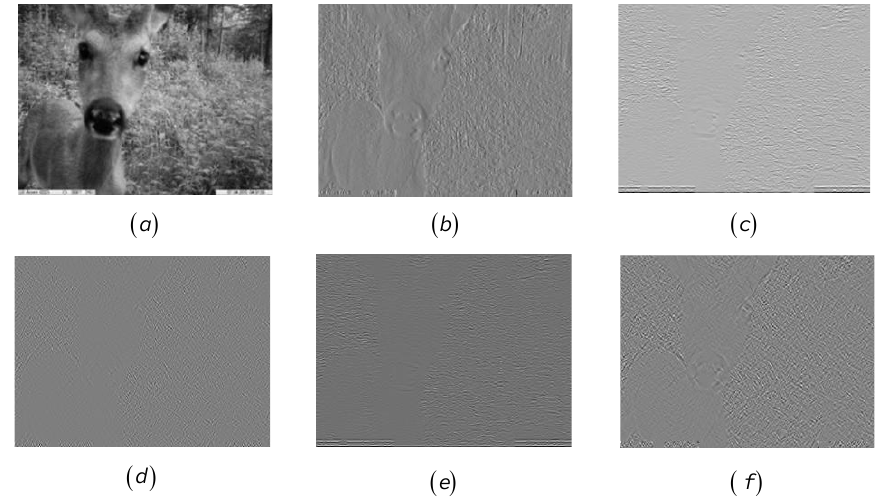
Figure 6. Polynomial convolution texture information; ( a ) H 11 ; ( b ) H 12 ; ( c ) H 31 ; ( d ) H 23 ; ( e ) H 41 ; and ( f ) H 22 .